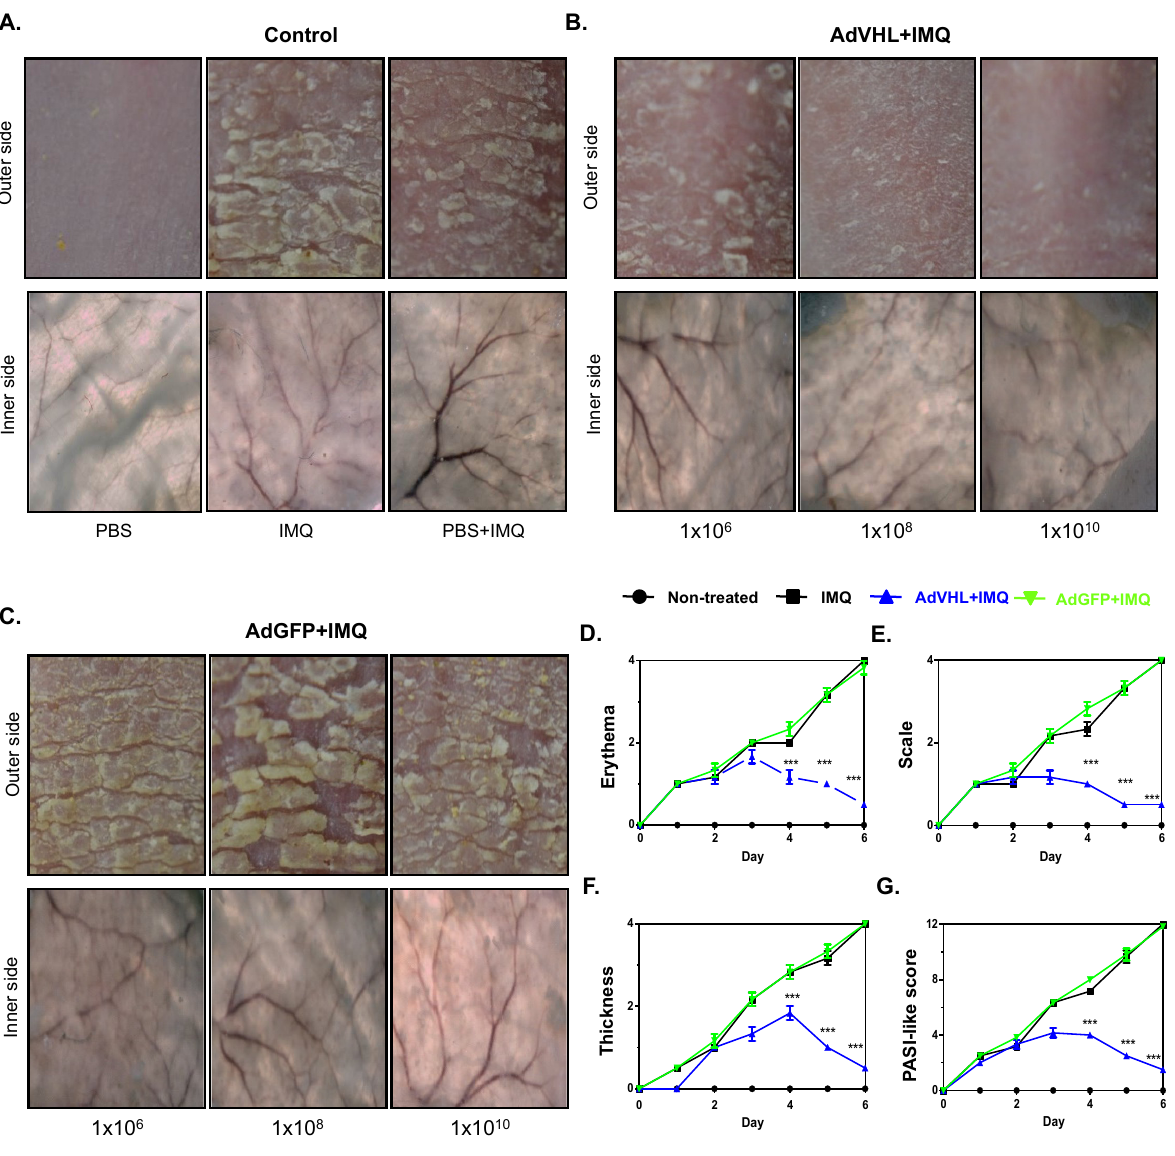
Figure 3. pVHL expression ameliorates the lesions in the imiquimod-induced psoriasis model. Mice were topically treated with 6.25 mg of imiquimod (IMQ) over six days, and skin changes were photographed and scored (n = 4). ( A ) Representative images from psoriatic skin (upper panels) and vascularity (lower panels) in mice that only received PBS or IMQ at day 6. Prior to IMQ application (24 h), the mice were injected with 1 × 10 6 , 1 × 10 8 or 1 × 10 10 PFU of ( B ) AdVHL or ( C ) AdGFP; in all conditions, psoriatic lesions and vascularity were registered at day 6. Evaluation of ( D ) erythema, ( E ) scale and ( F ) thickness present in skin treated with PBS, IMQ, AdVHL/IMQ or AdGFP/IMQ. Measurements were performed daily during the 6 days of the experiment on each mouse and scored based on skin changes (0: none, 1: slight, 2: moderate, 3: severe, 4: highly severe). ( G ) Pso- riasis-like index for the severity of mice psoriasis was calculated by adding erythema, scale and thickness observed in the skin. Data are represented as median and p value was calculated using the Kruskal–Wallis test. *** p < 0.001. Ad: Adenoviral vector, GFP: Green fluorescent protein, IMQ: Imiquimod, VHL: von Hippel-Lindau. 2.4. HIF-1 α and Its Downstream Mediators in Lesional Skin Are Negatively Regulated by pVHL To elucidate the mechanism underlying the inhibition of psoriatic features in the mouse model caused by the retrieval of pVHL, we determined the expression of pVHL in